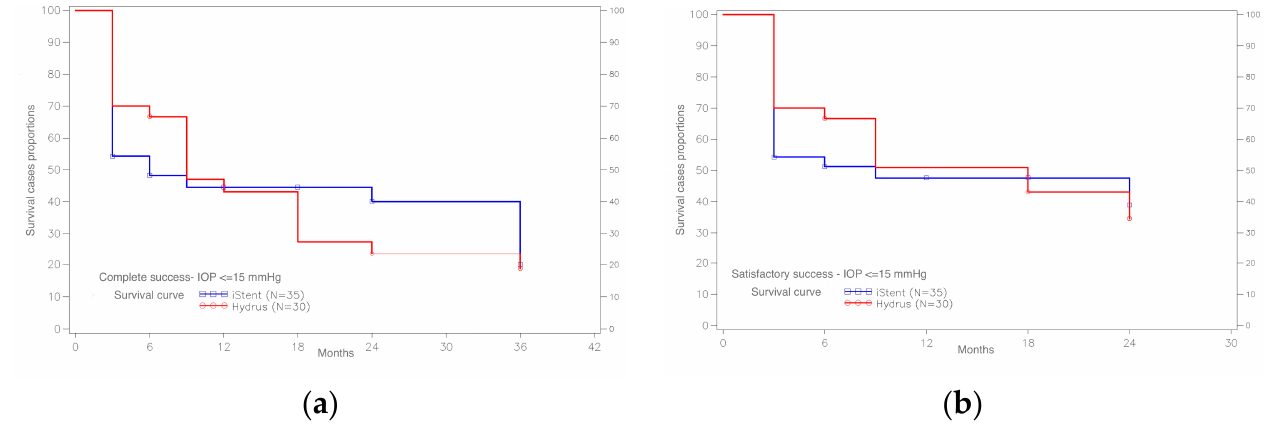
Figure 5. ( a ) Distribution of survival curves for complete surgical success for the IOP criterion ≤ 15 mmHg, for the Hydrus and iStent , and ( b ) distribution of survival curves for satisfactory surgical success for the IOP criterion ≤ 15 mmHg, for the Hydrus and the iStent. Figure 6 shows hazard ratio estimates for Hydrus and iStent at 24 months postoper- atively.